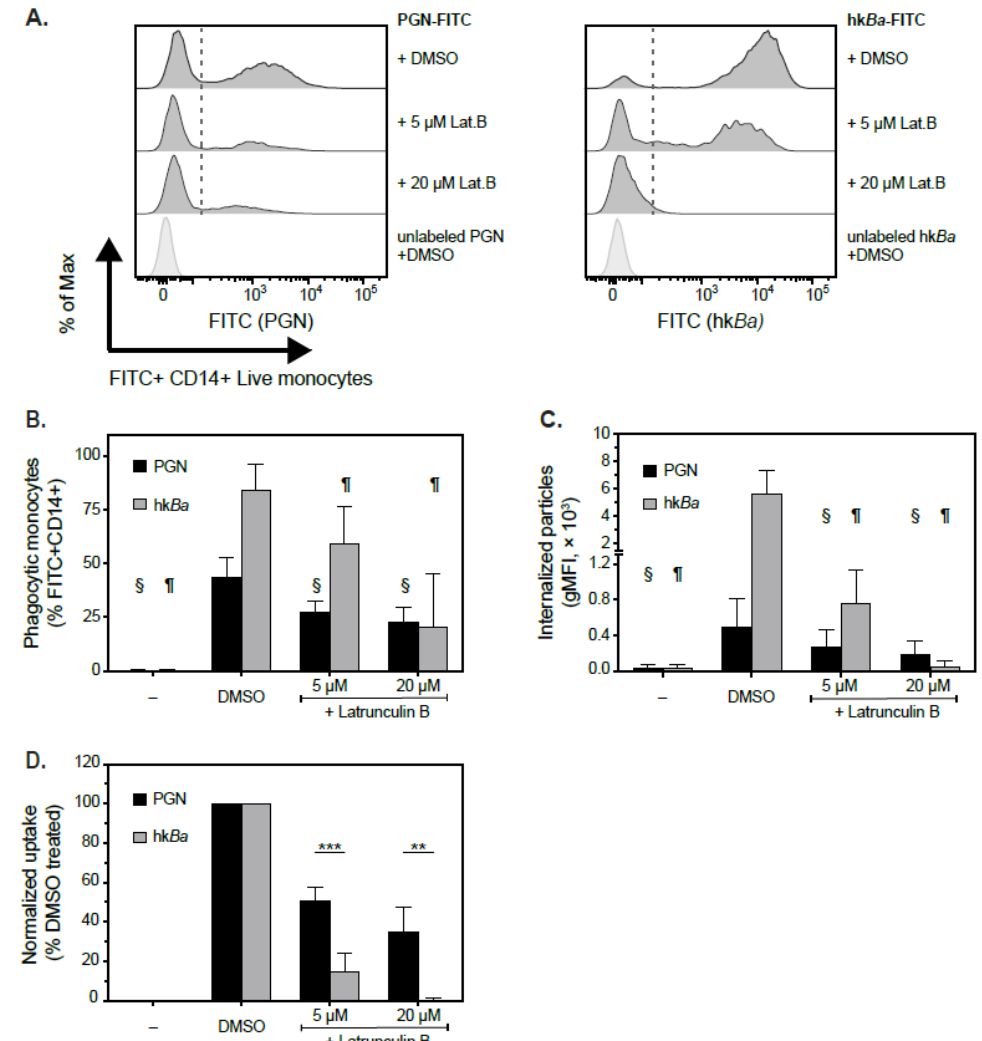
Figure 2. Comparison of latrunculin inhibition of PGN and hk Ba internalization by primary human monocytes. ( A ) Representative histogram overlays of a median responsive individual depicting paired internalization of PGN-FITC (left) and hk Ba -FITC (right) in CD14+ monocytes pretreated with DMSO (top) or either 5 µM or 20 µM latrunculin B (Lat.B). For comparison, the internalization of unlabeled PGN in DMSO-treated monocytes is shown in the bottom panel, while the threshold used to assess phagocytic cells is depicted graphically as a segmented line. ( B , C ) Summary representation of changes in monocyte internalization of FITC labeled particles, either PGN (black bars) or hk Ba (grey bars), after latrunculin treatment. Data depict mean ± standard deviation of phagocytic monocytes (%FITC+ CD14+; ( B )) or adjusted internalized fluorescence intensity (geometric mean fluorescence intensity, gMFI; ( C )) of 6 independent experiments. Differences between groups were analyzed by repeated-measures two-way ANOVA with Holm-Sidak’s multiple comparison correction (§ depicts significant changes, p ≤ 0.05, compared to PGN-FITC internalization by DMSO-treated monocytes; ¶ depicts significant changes, p ≤ 0.01, compared to hk Ba -FITC internalization by DMSO-treated monocytes). ( D ) Latrunculin effects on PGN and hk Ba internalization after pairwise normalization to particle uptake in DMSO treated cells by the same donor. Statistically significant differences between latrunculin’s effects on PGN vs. hk Ba uptake are depicted conventionally (** p < 0.01, *** p < 0.001).